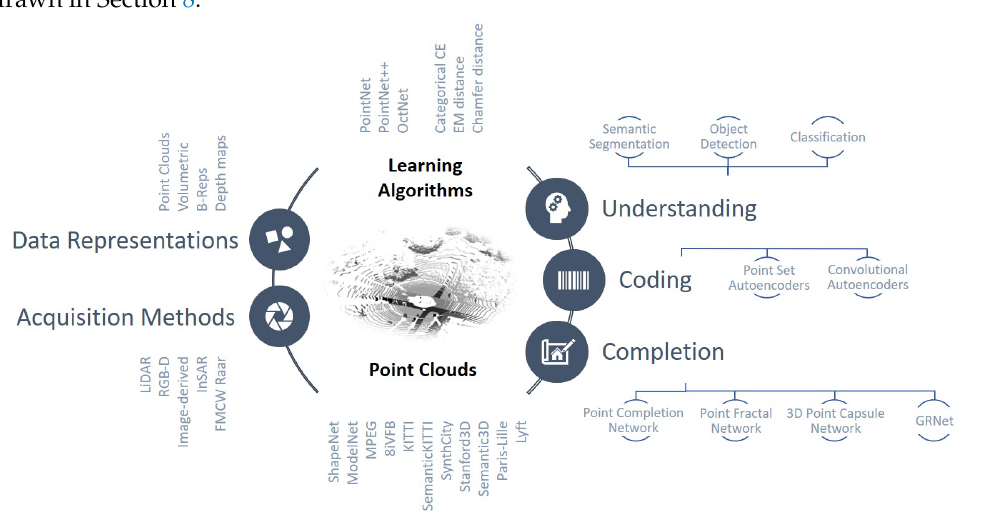
Figure 1. Schematic representation of the paper